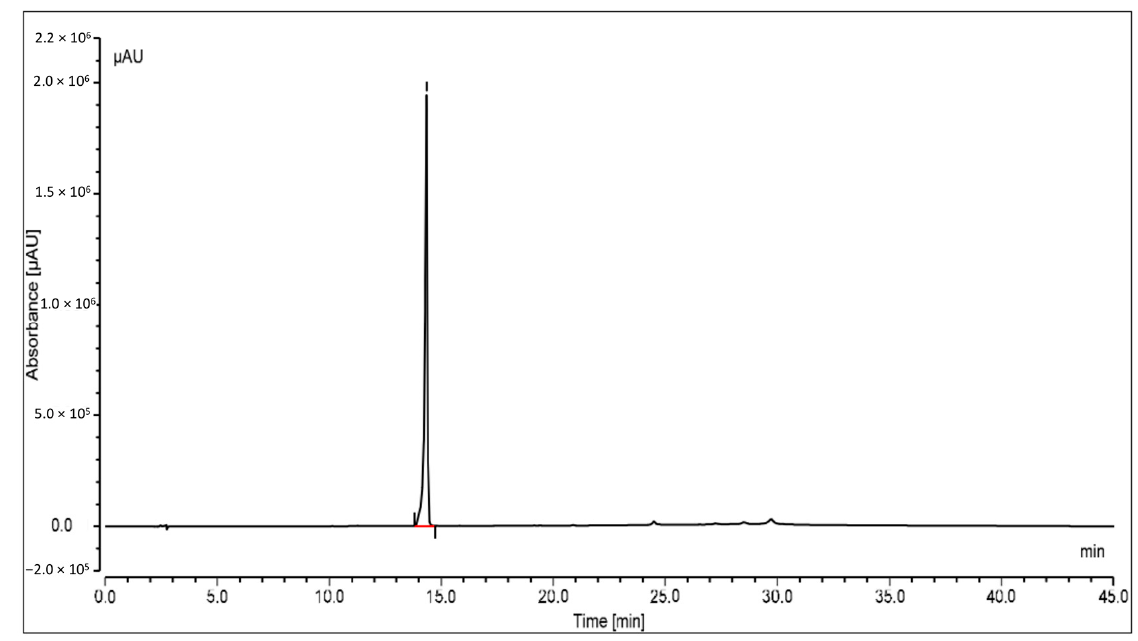
Figure 3 . HPLC peak of standard oleanolic acid. Figure 3. HPLC peak of standard oleanolic acid.